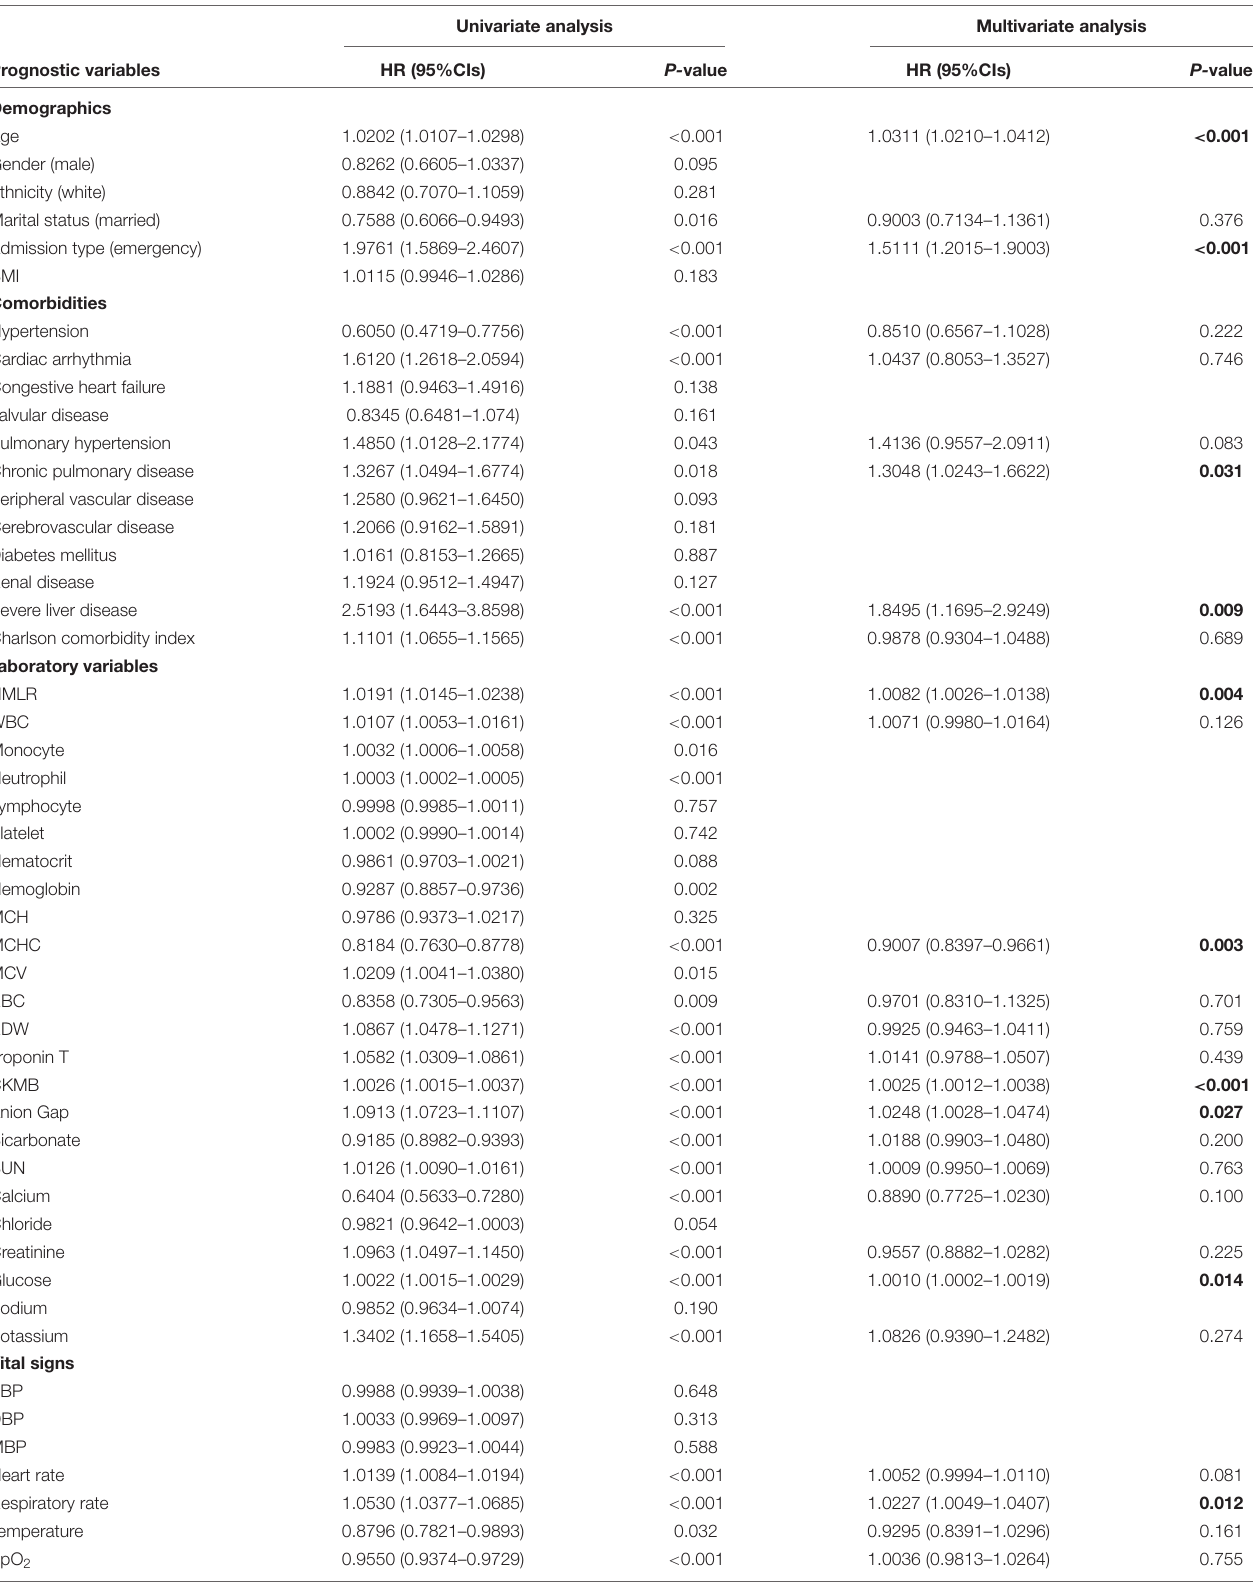
TABLE 2 | Univariate and multivariate analysis of prognostic